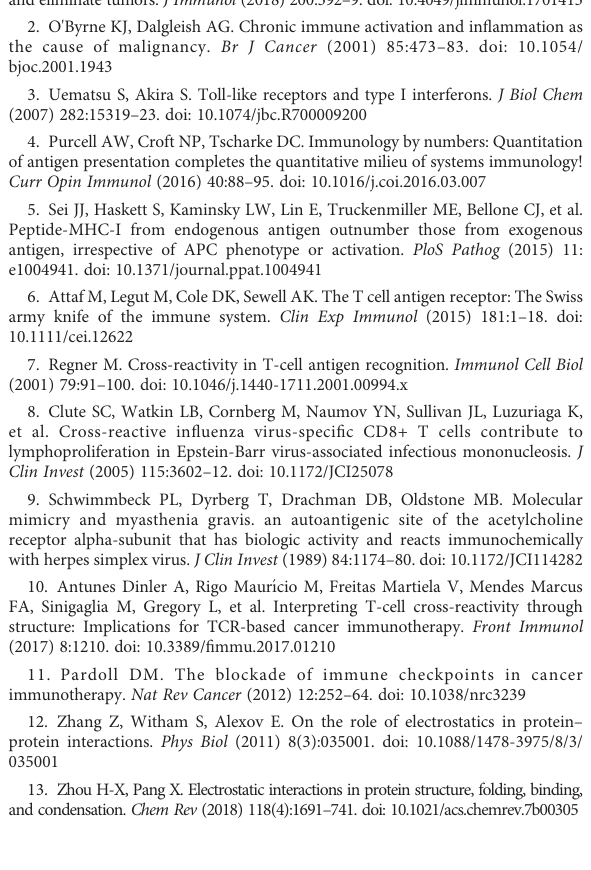
List of MHC peptide linear sequences and their respective names. Cells of the same color indicate the existence of in vitro data demonstrating some level of cross-reactivity event.